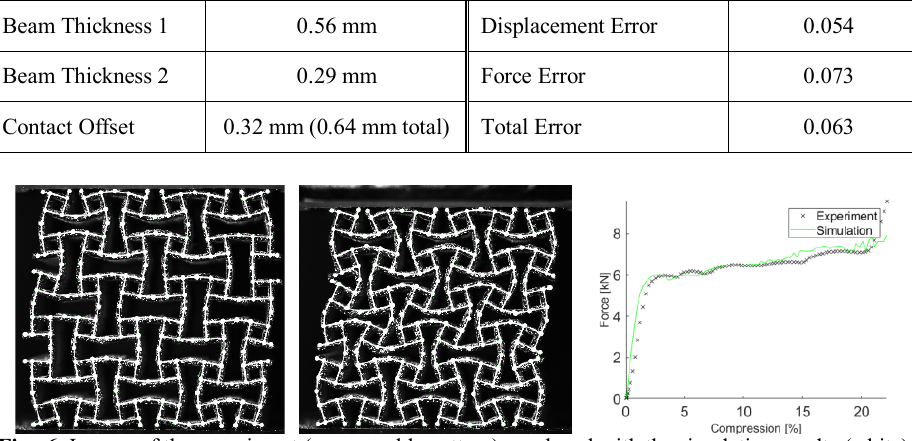
Fig. 6. Images of the experiment (gray speckle pattern) overlayed with the simulation results (white) at 10 % and 20 % compression. The difference between experimental and simulation deformation is hardly